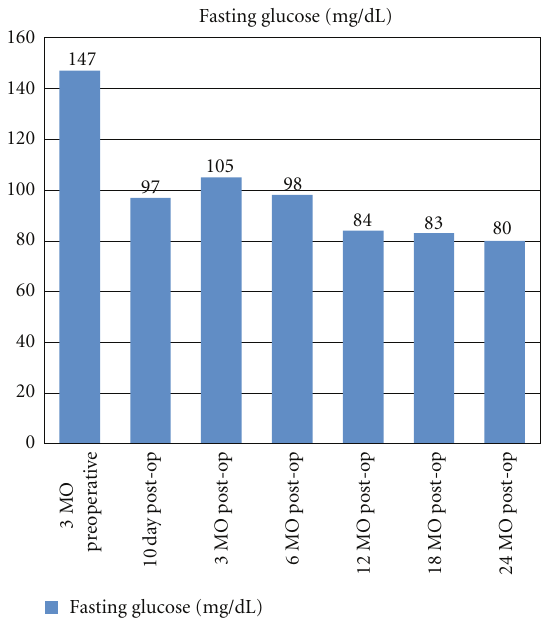
Figure 1: Patient’s fasting glucose 3 months preoperatively through 24 months postoperatively.